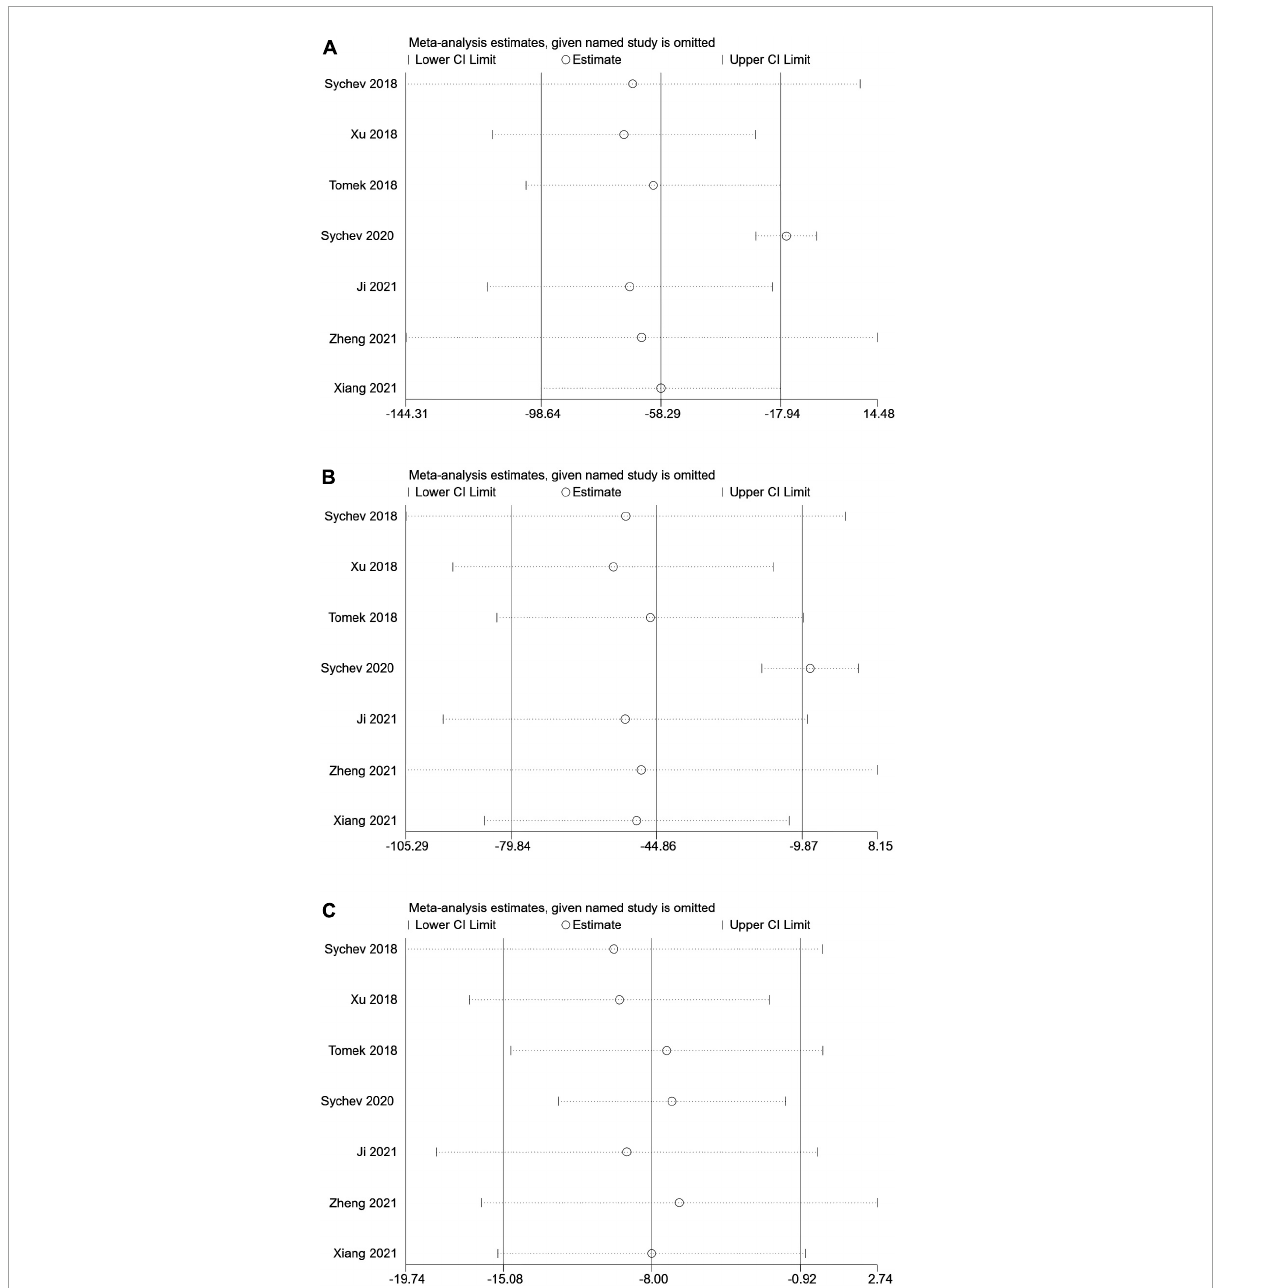
FIGURE3 Sensitive analysis of carboxylesterase 1 ( CES1 ) rs2244613 polymorphism and the trough plasma concentration of dabigatran: (A) homozygote model, (B) recessive model, and (C) allelic model.